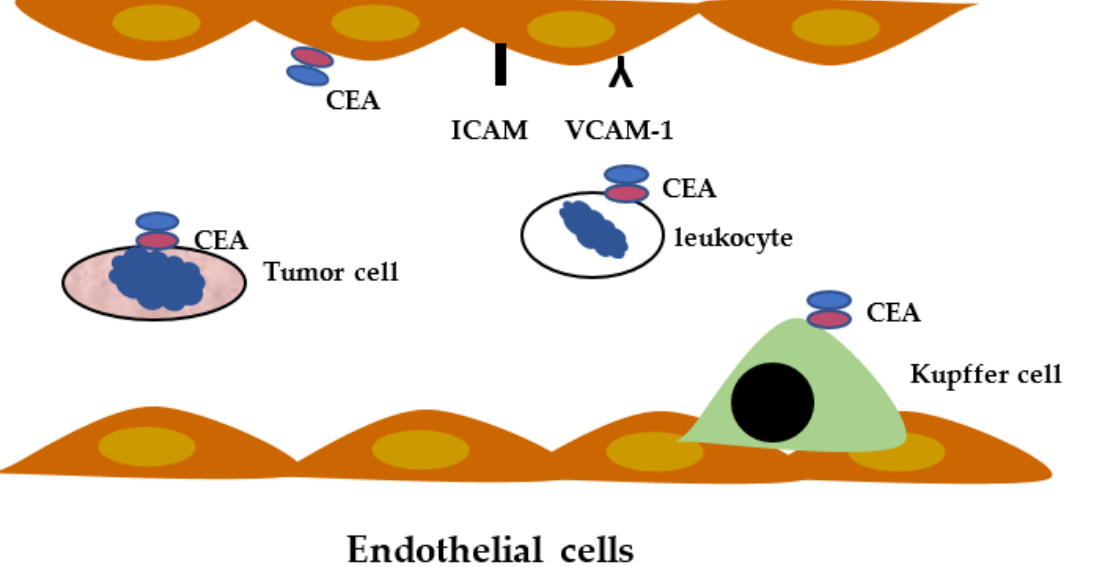
Figure 2. Carcinoembryonic antigen cell adhesion molecule (CEACAM) expression on cells. The CEA- CAM IgG superfamily may be present on normal endothelial cells, leukocytes, Kupffer cells and tumor cells (colon, breast). They are involved in cell adhesion and recognition. They participate in homophilic and heterophilic cell adhesion, facilitating migration and metastasis. CEA represents CEACAM, ICAM intercellular cell adhesion molecule, and VCAM-1 vascular cell adhesion molecule-1.